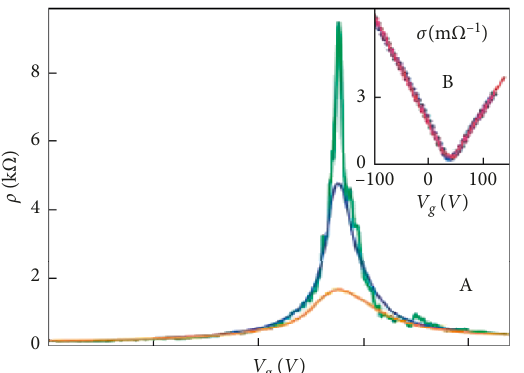
Figure 16: Resistivity of a single layer of graphene vs gate voltage [44].